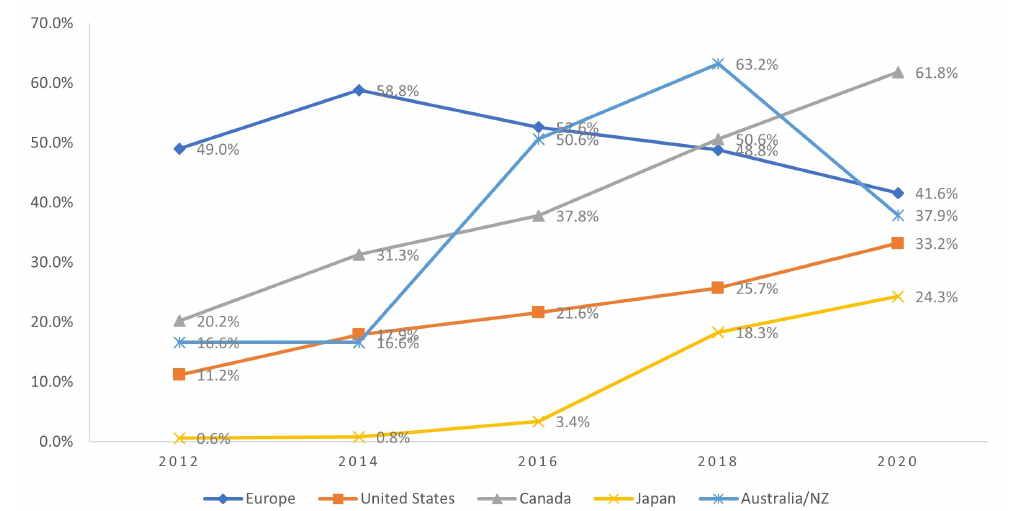
Figure A3. Proportion of sustainable investing assets relative to total manager assets